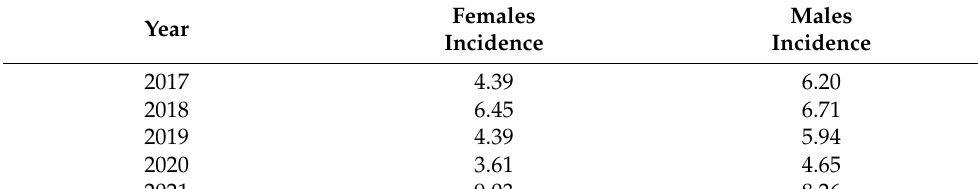
Table 1. Incidence rates (per 100,000) of T1DM by gender during 2017–2021 in Vojvodina. Females Year